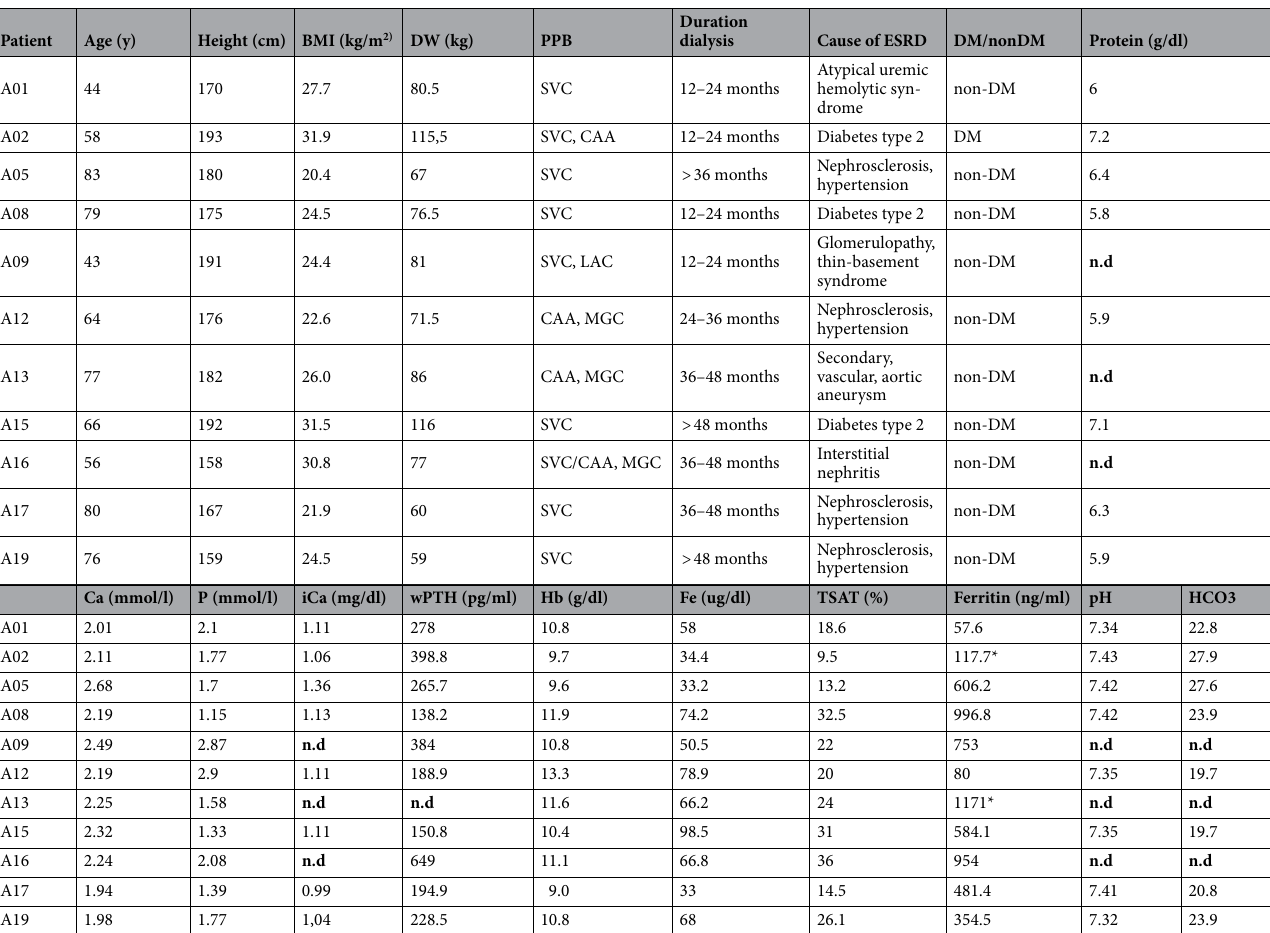
Table 1. Clinical baseline characteristics of each patient. BMI = body mass index, DW = dry weight on dialysis, ESRD = end-stage renal disease, PPD = primary phosphate binder (SVC = sevelamer carbonate, CAA =